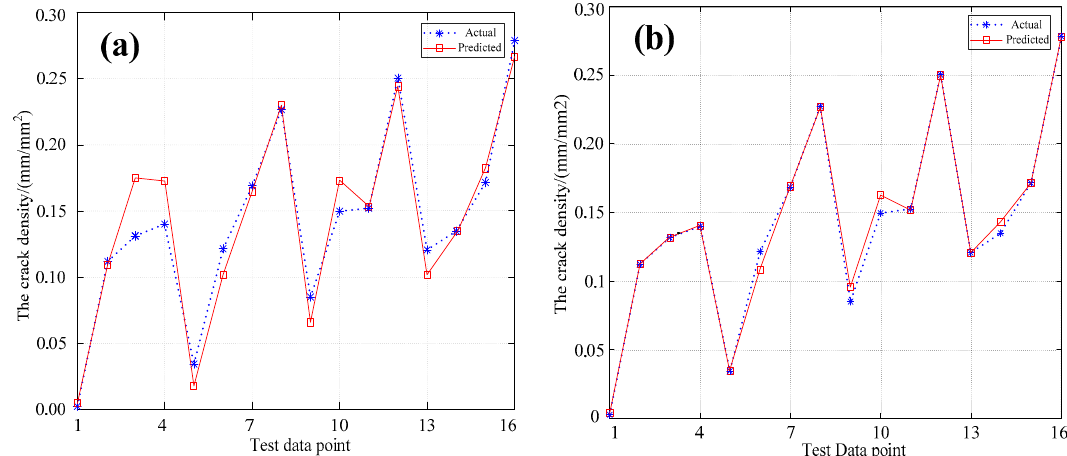
Figure 8. Comparison of the predicted results. ( a ) Neural network prediction simulation diagram. ( b ) Genetic algorithm-optimized neural network prediction simulation diagram.